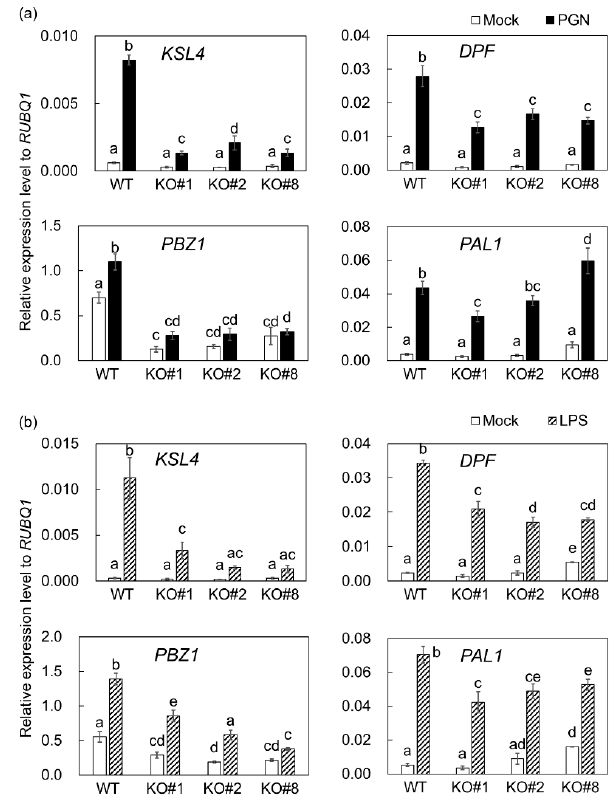
Figure 2. MAMP-induced transcript levels of defense-related genes were suppressed in BSR1 -knockout suspension-cultured rice cells. The PBZ1 , PAL1 , KSL4 , and DPF transcript levels at 3-h post treatment with peptidoglycan ( a ) and LPS ( b ) were normalized against the RUBQ1 internal control levels. Values are presented as the means ± standard deviations of three biological replicates. Experiments were conducted two times with similar results. Di ff erent letters indicate significant di ff erences (Tukey’s test; p < 0.05). PGN, peptidoglycan; KO, knockout line; KO#1, bsr1-1 #13-1; KO#2, bsr1-2 #16-2; KO#8, bsr1-8 #5-1; WT, wild-type; LPS,